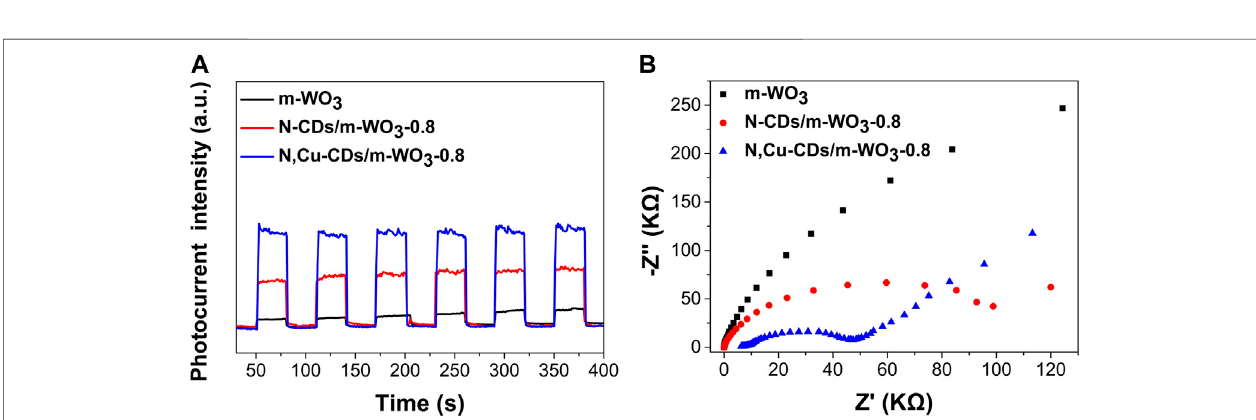
FIGURE 6 | PEC properties of as-synthesized samples: photocurrent response (A) and EIS measurement (B) .